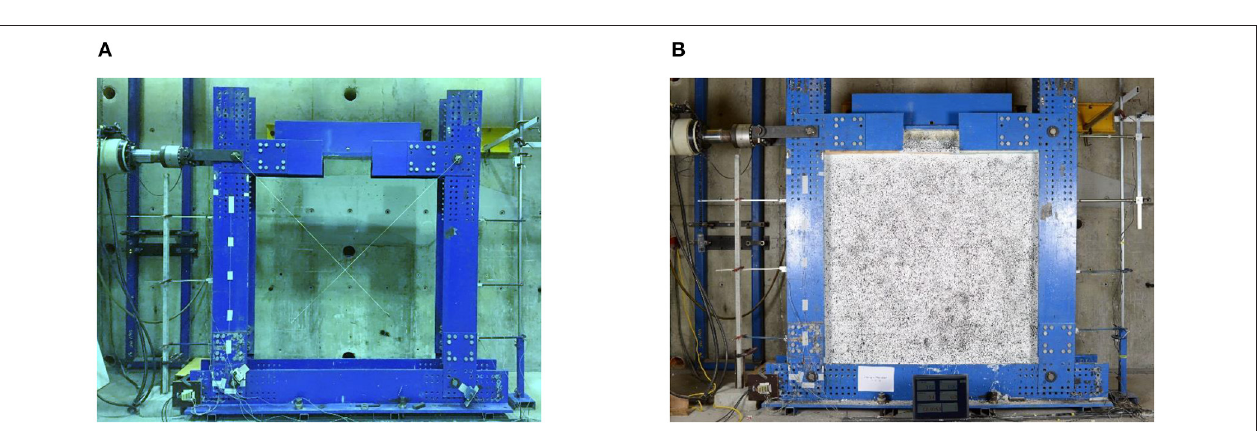
FIGURE 16 | Picture of the specimens. (A) Bare Frame. (B) General vision of the steel frame infilled with a semi-interlocking masonry (SIM)